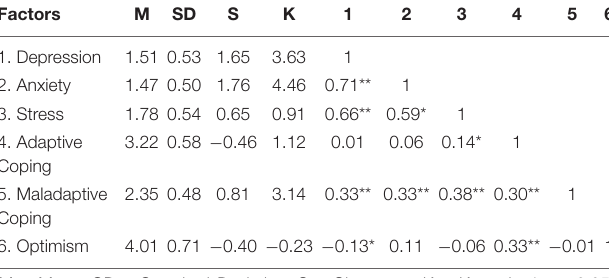
TABLE 2 | Descriptive statistics and correlations.